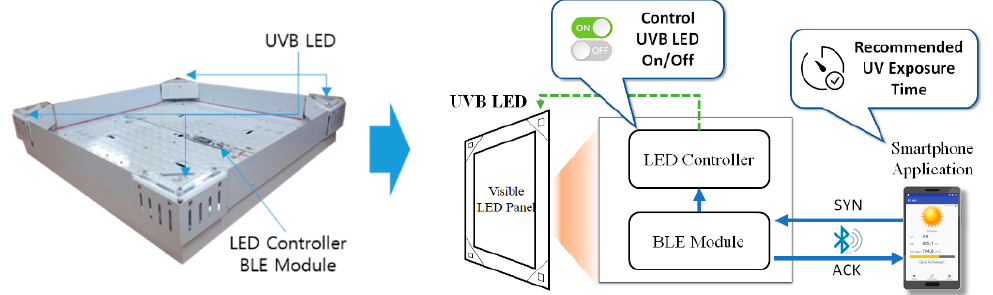
Figure 4. UVB LED general lighting and block diagram of UVB LED general lighting.